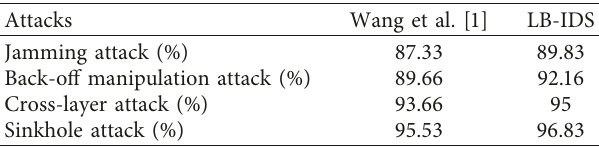
Table 3: Average of detection